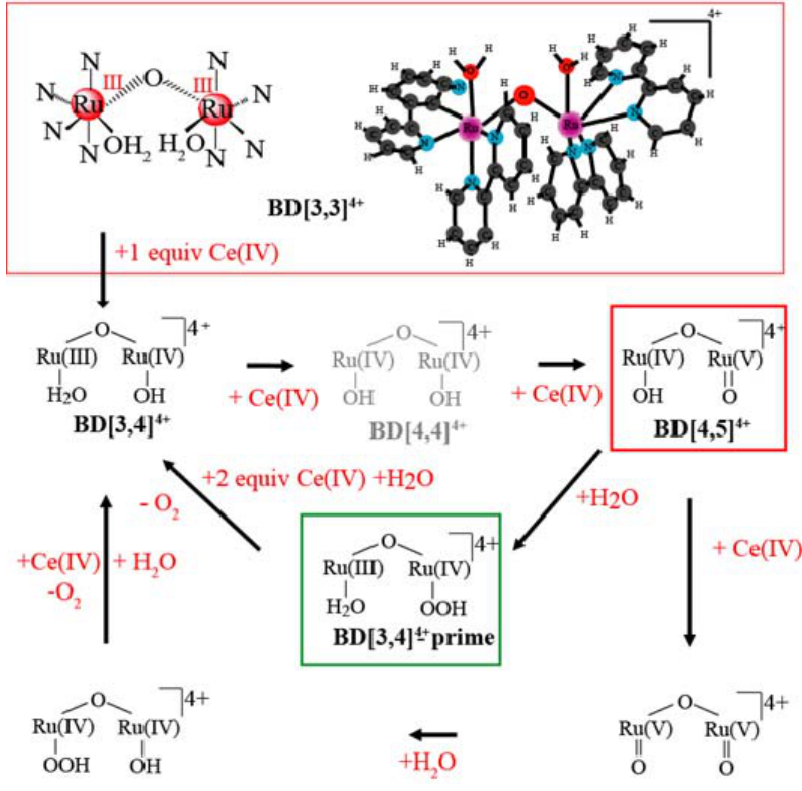
Figure 1. Mechanism of blue dimer (BD) water